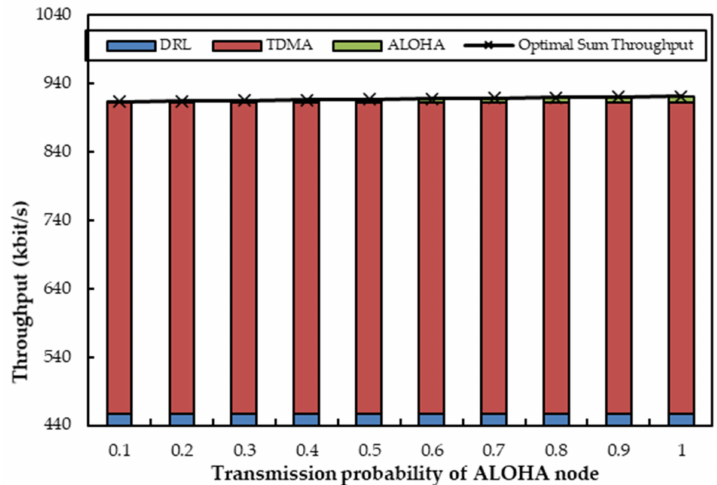
Figure 9. Sum throughput when one agent coexists with one acoustic ALOHA node and one optical TDMA node, which have fixed R and variable q .